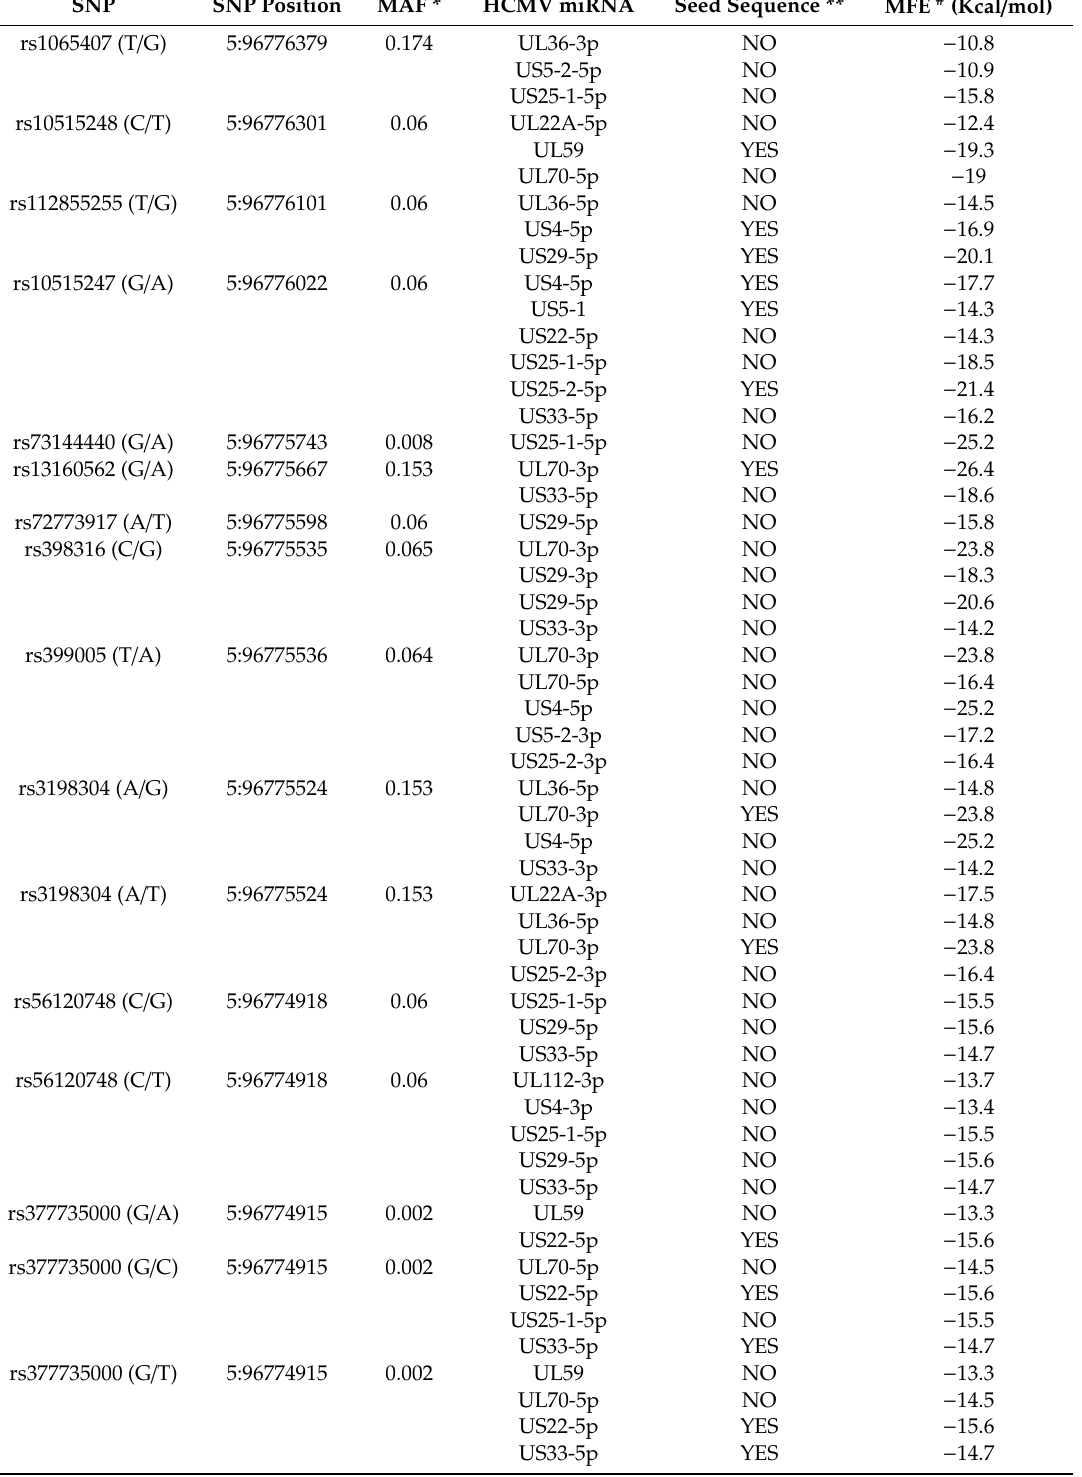
Table 2. HCMV miRNAs targeting the 3 (cid:48) UTR of ERAP1 gene in polymorphic sites in which the alternative allele prevents the miRNA